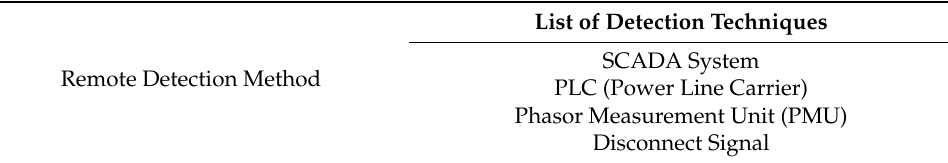
Table 2. Remote Islanding Detection Methods